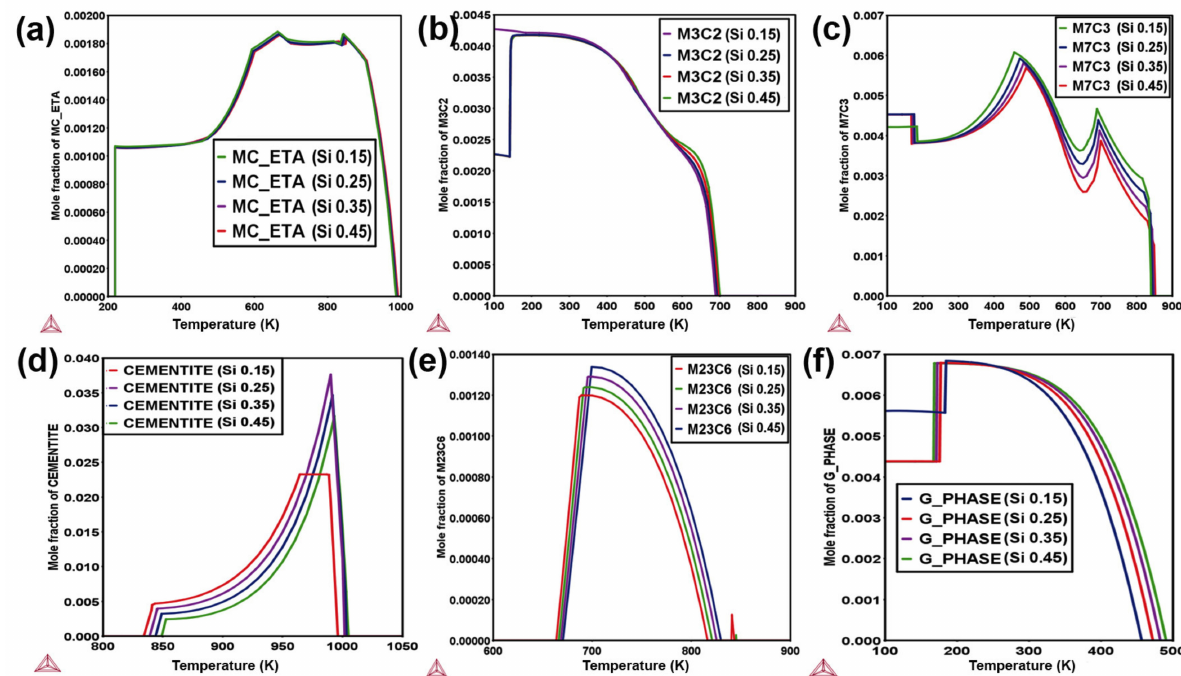
Figure 4. Effect of Si concentration to MS3 alloys for, ( a ) MC-ETA; ( b ) M 3 C 2 ; ( c ) M 7 C 3 ; ( d ) cementite; ( e ) M 23 C 6 ; ( f )